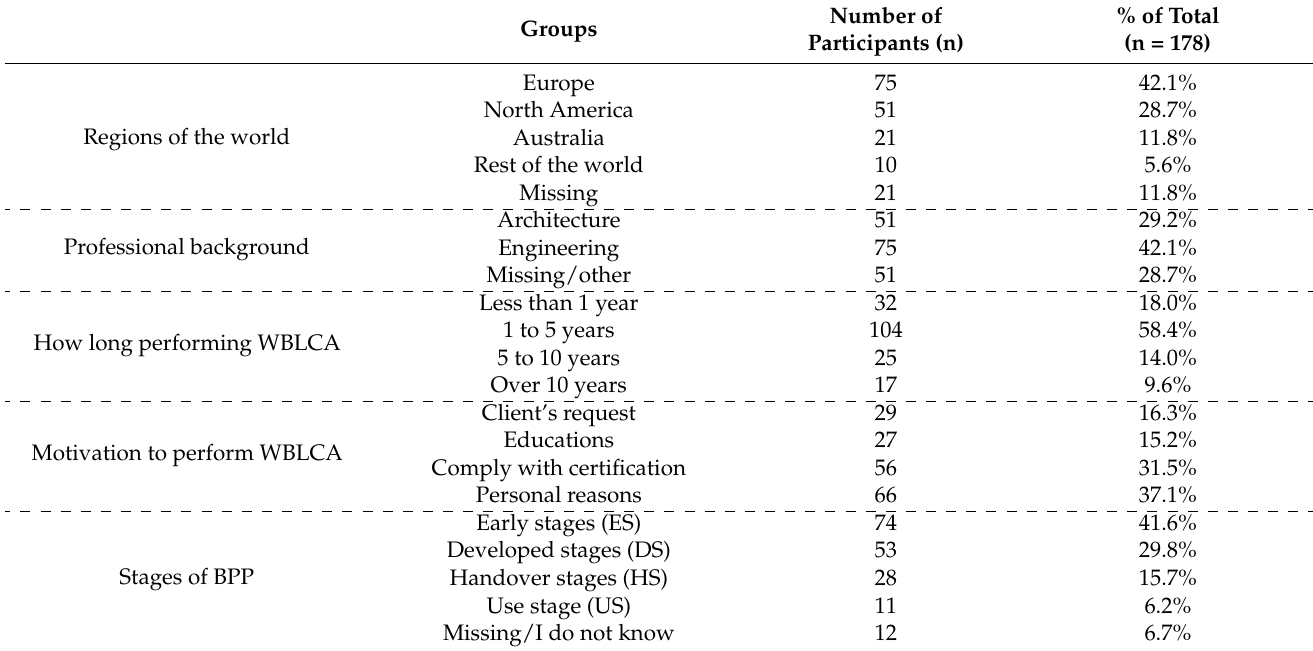
Table 3. Groups of